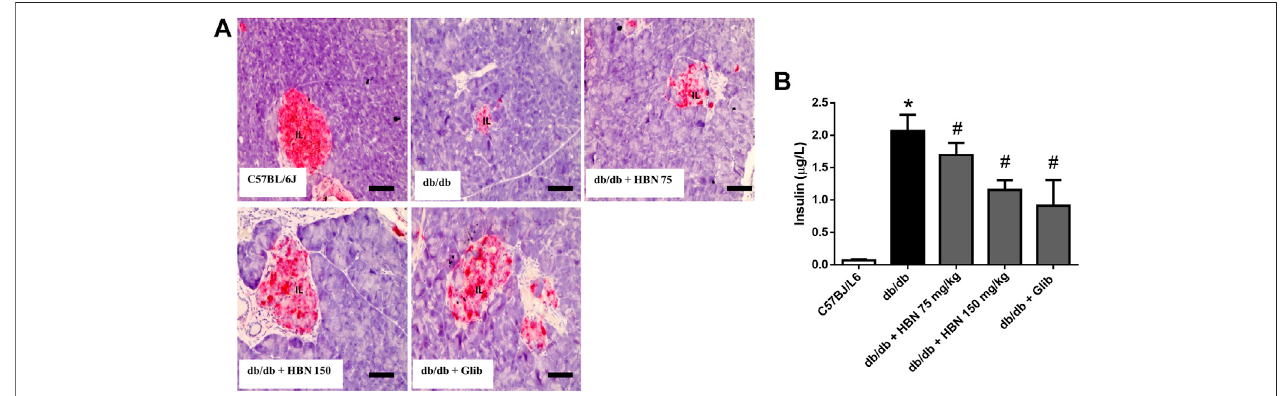
FIGURE 3 | Effects of HBN (75 and 150 mg/kg) and glibenclamide (1 mg/kg) treatment on insulin content. (A) Representative immunoperoxidase images showing insulin distribution in the pancreatic islets. The sites of distribution are indicated by dark brown staining. Scale bar (cid:2) 50 μ m. Magni fi cation × 40 (B) Serum insulin level (µg/L). Values are expressed as mean ± S.E.M of six experiments. * p < 0.05 compared to C57BL/6J mice, # p < 0.05 compared to db/db mice.